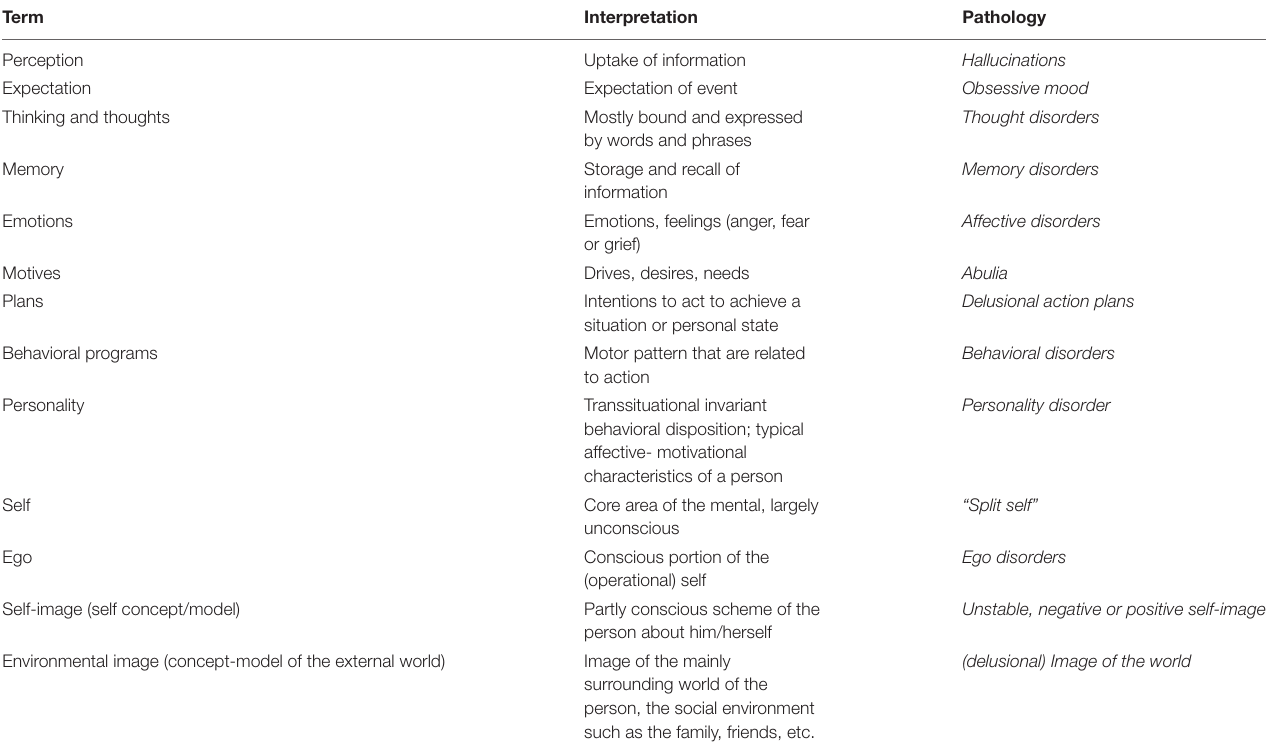
TABLE 1 | Concepts of mental operations and operators and some disorders.